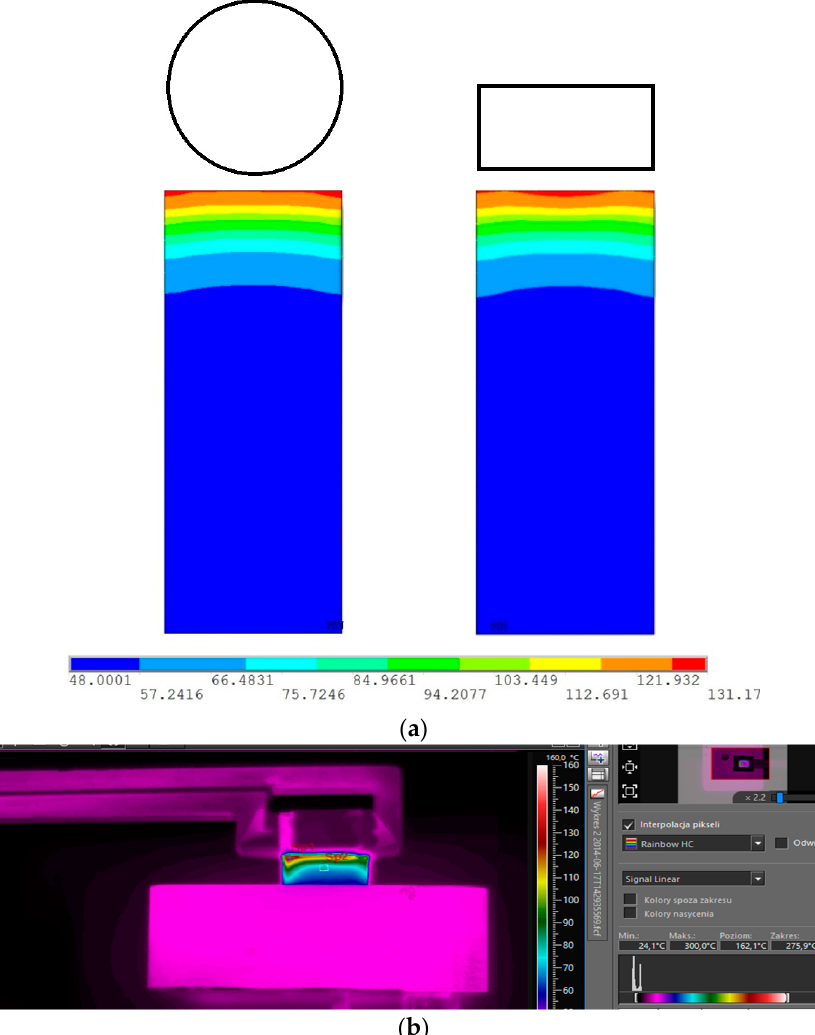
Figure 13. ( a ) The comparison of temperature profile of heated insert with different shapes of inductors heating time was equal to 2.5 s and the distance between inductor and surface was equal to 1 mm. ( b ) Measurement of the surface temperature heated with an induction coil.